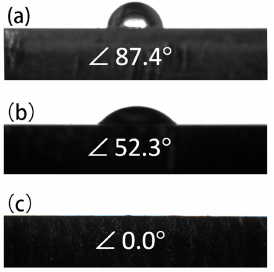
Figure 6. Photograph of water droplet on the surface of ( a ) uncoated Mg alloy; ( b ) MgF 2 -coated Mg alloy; ( c ) Mg-MOF-74/MgF 2 -coated Mg alloy.